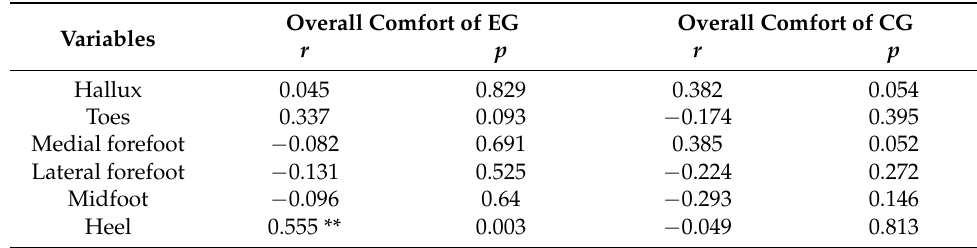
Table 4. Pearson correlation coefficients ( r ) and p-values ( p ) for overall comfort and plantar foot pressure.